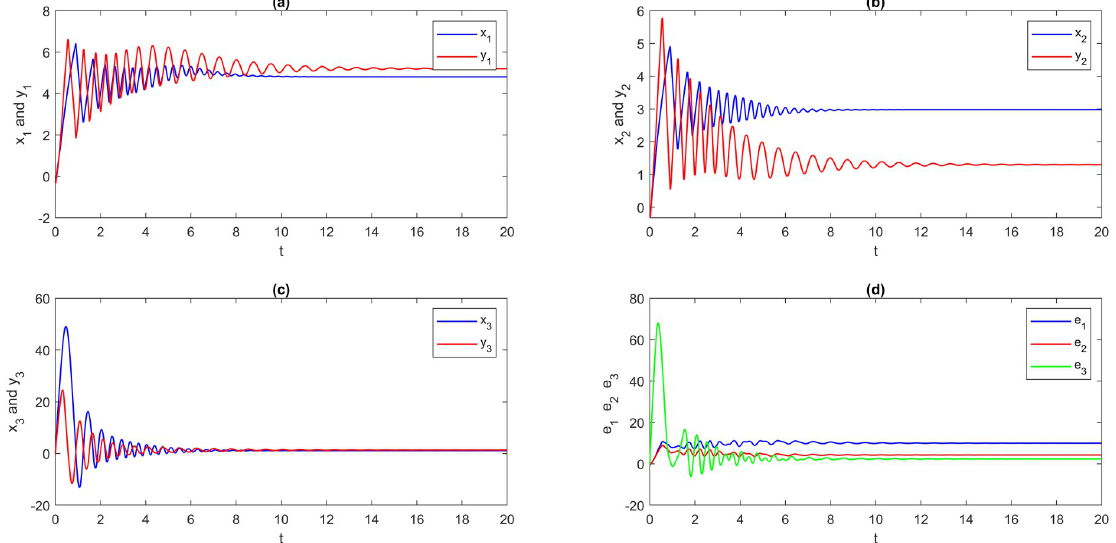
Fig 3. Multi-time delay of multi-FONNSMD synchronization without controller activation. (a) x 1 versus y 1 , (b) x 2 versus y 2 , (c) x 3 versus y 3 , and (d) Synchronization